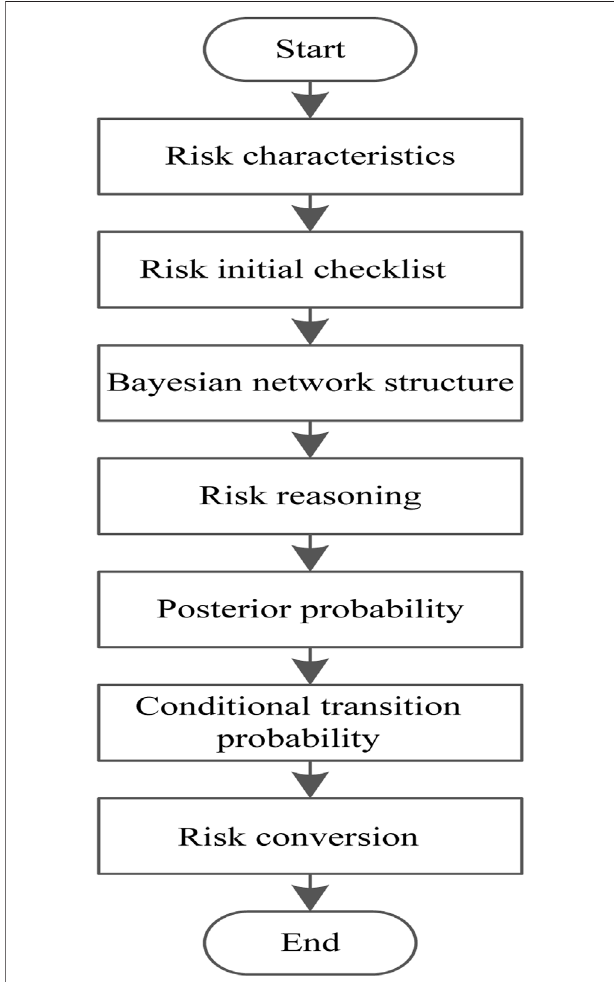
FIGURE 6 | Flow chart of safety risk management and control of power trading